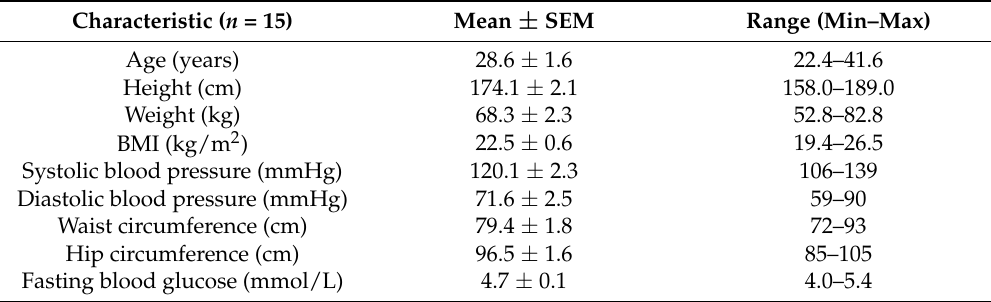
Table 2. Anthropometric characteristics of the study participants ( n =